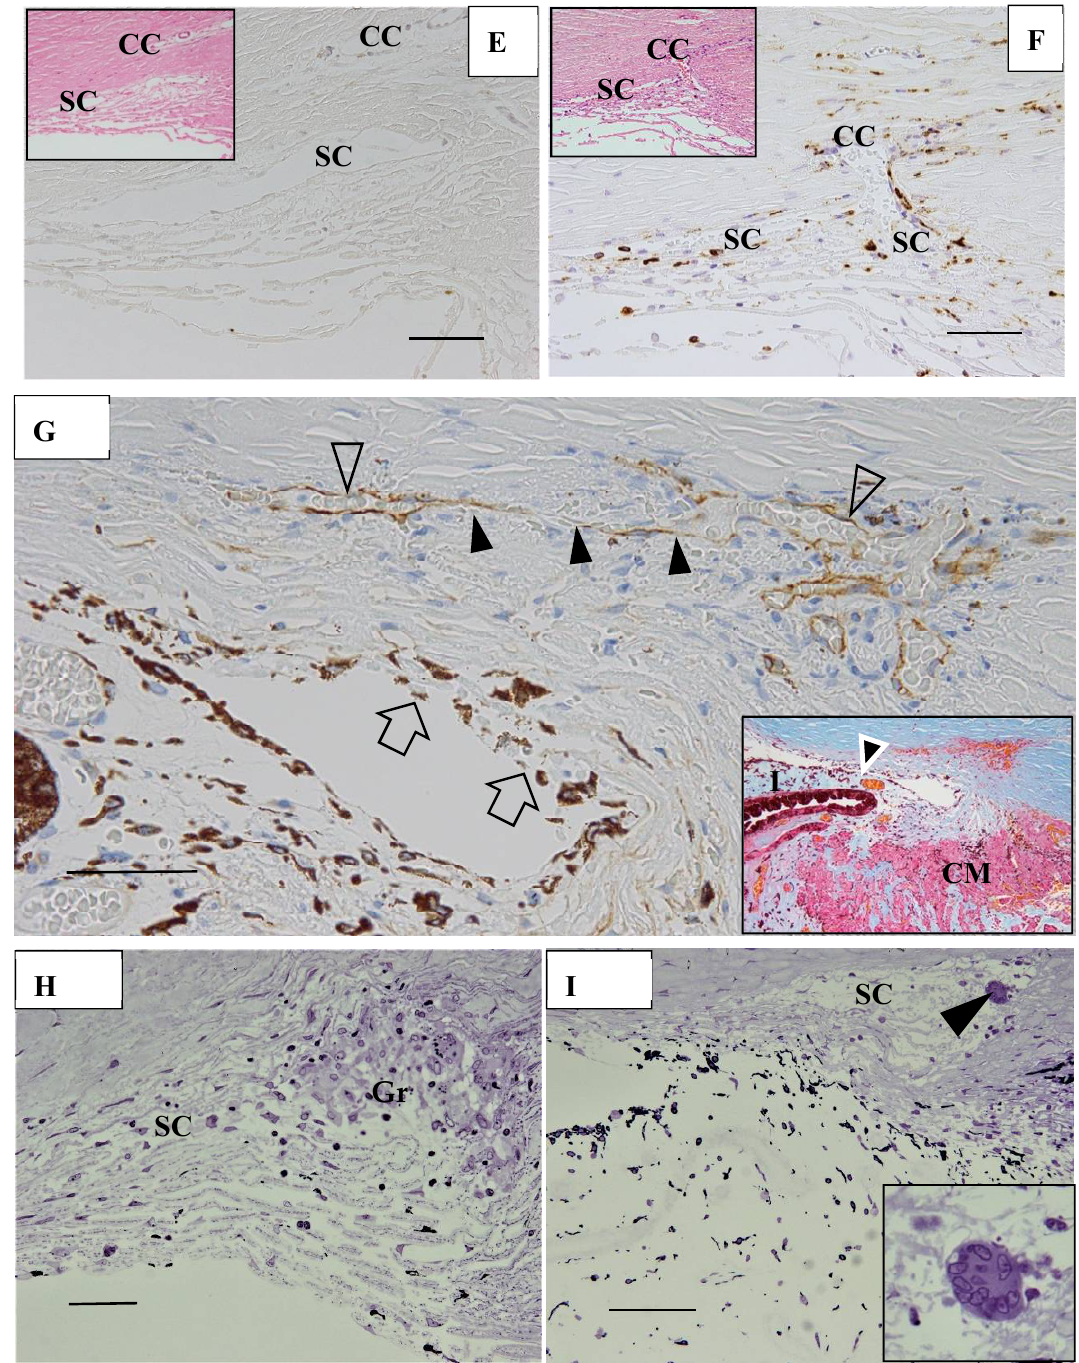
Figure 16. ( A – F ). Light microscopy photographs of the angle in trabeculectomy (TRAB) specimens. ( A – F ) immunohistochemical staining of CD68. ( A – F inset) Hematoxylin eosin stain of paraffin embedding. ( A ) Image of the right eye in Case 24, a 39-year-old female in Group I with a max IOP of 34 mmHg; ( B ) Image of the right eye in Case 21, a 72-year-old female in Group I with a max IOP of 32 mmHg; ( C ) Image of the left eye in Case 23, a 72-year-old male in Group I with a max IOP of 35 mmHg; ( D ) Image of the left eye in Case 20, a 72-year-old male in Group I with a max IOP of 50 mmHg; ( E , F ) Image of the left eye in Case 44, a 74-year-old male in Group III with a max IOP of 54 mmHg. Scale bar: 50 μm. Granuloma (Gr) was found in the pupil area, around the collector channel (CC, open arrowhead in B ), in the Schlemm’s canal (SC, solid arrow-heads in B and C ), and the iris root (Gr in D , arrowhead in D inset). CD68-positive cells were not found with a continuous topical betamethasone (CTB) in the first TRAB ( E ), but were found around the SC, collector channel ( CC ), and in the trabecular meshwork in the second TRAB. This eye was a dilemma case of super mild steroid responder. When CTB (4 to 6 times daily) was continued for 7 months, IOP temporally decreased from 36 mmHg to 15 mmHg. However, it started to increase to 23 mmHg, so CTB was discontinued for 1 week and IOP increased again to 34 mmHg. The second TRAB was then performed in 4 days after the restart of the topical betamethasone. CD-positive cells and lymphocytes infiltration still remained in the SC and the CCs; ( G ) Light microscopy photographs of the angle obtained from TRAB in the right eye of Case 27, a 33-year-old female in Group II with a max IOP of 38 mmHg (thrombomodulin immunohistochemical stain). The inset is a lower magnification image of photo G (Masson trichrome stain). CM: ciliary muscle, I: iris, arrowhead in inset: peripheral anterior synechia (PAS). Scale bar: 50 μm. The patient was referred to our hospital in December 1991 due to BHL. Perivascular nodules in the retina and slight inflammation in the anterior chamber were found. IOP had remained at 12–14 mmHg in both eyes for 18 years. IOP in her right eye started to increase to 20 mmHg from March 2009, and topical betamethasone was then started. However, the patient administered the medication irregularly. PAS with 50% (arrowhead in G , inset) occurred at 21 months of absence from our hospital. IOP in her right eye increased to 38 mmHg and VFD worsened from normal (March 2011) to Stage V (January 2016) in A-G classification. Because of no response to IOP (i.e., IOP fluctuated around 30 mmHg) by topical betamethasone and glaucoma medication, TRAB combined with tube-shunt surgery was performed in October 2016. Only a small part of Schlemm’s canal (SC) remained open (open arrowheads) and the center part of SC became occluded (solid arrowheads). There was infiltration of melanocytes on the surface of trabecular meshwork (arrows in G ). No inflammation in the anterior chamber and no elevation of IOP was observed with continuous topical betamethasone administered 3-times daily for 4-years postoperative; ( H , I ) Light microscopy photographs of the angle at the 9-o’clock position in the left eye of Autopsy Case 1 ( H ), a 75-year-old female, and at the 9-o’clock position in the left eye of Autopsy Case 2 (I), a 78-year-old female. The inset in I is a high magnification image of the granuloma (arrowhead in I ). Methylmethacrylate embedding, toluidine blue stain. Granulomas (Gr in H , arrowhead in I ) were found in the Schlemm’s canal (SC). The SC is almost occluded in photos H and I . The granuloma composed of epithelioid cells appeared to be shrinking and disappearing ( I inset). Scale bar in F , G : 50 μm.